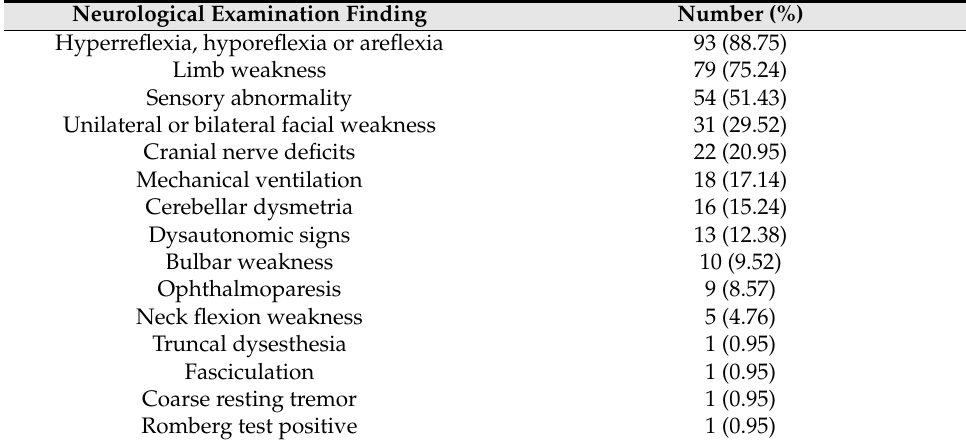
Table 5. Neurological examination